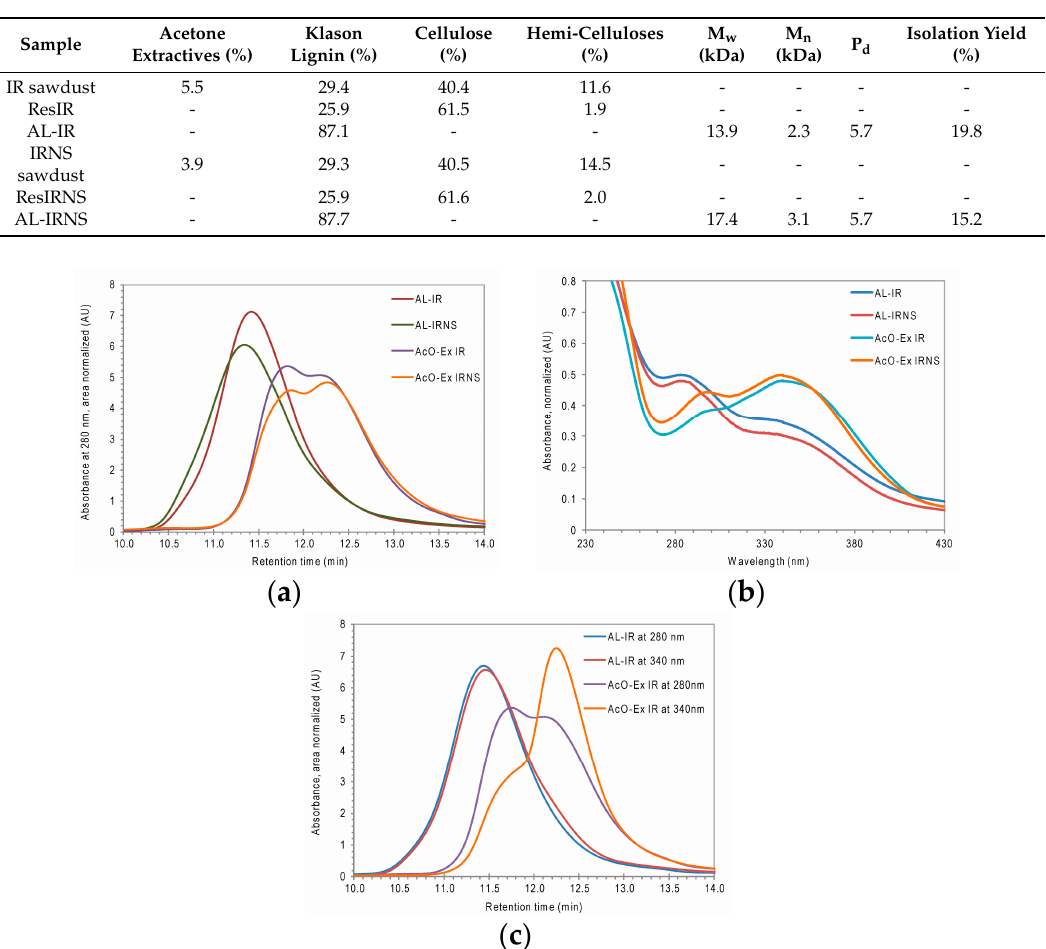
Table 1. Extractives and Klason lignin contents of the different wood samples, the respective isolated